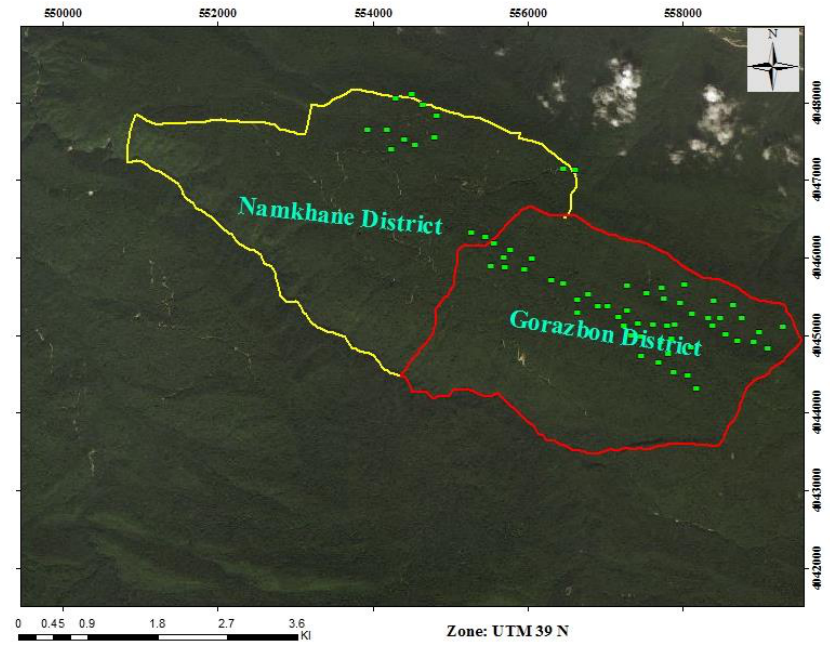
Figure 1. Location of the plots in Khyroud